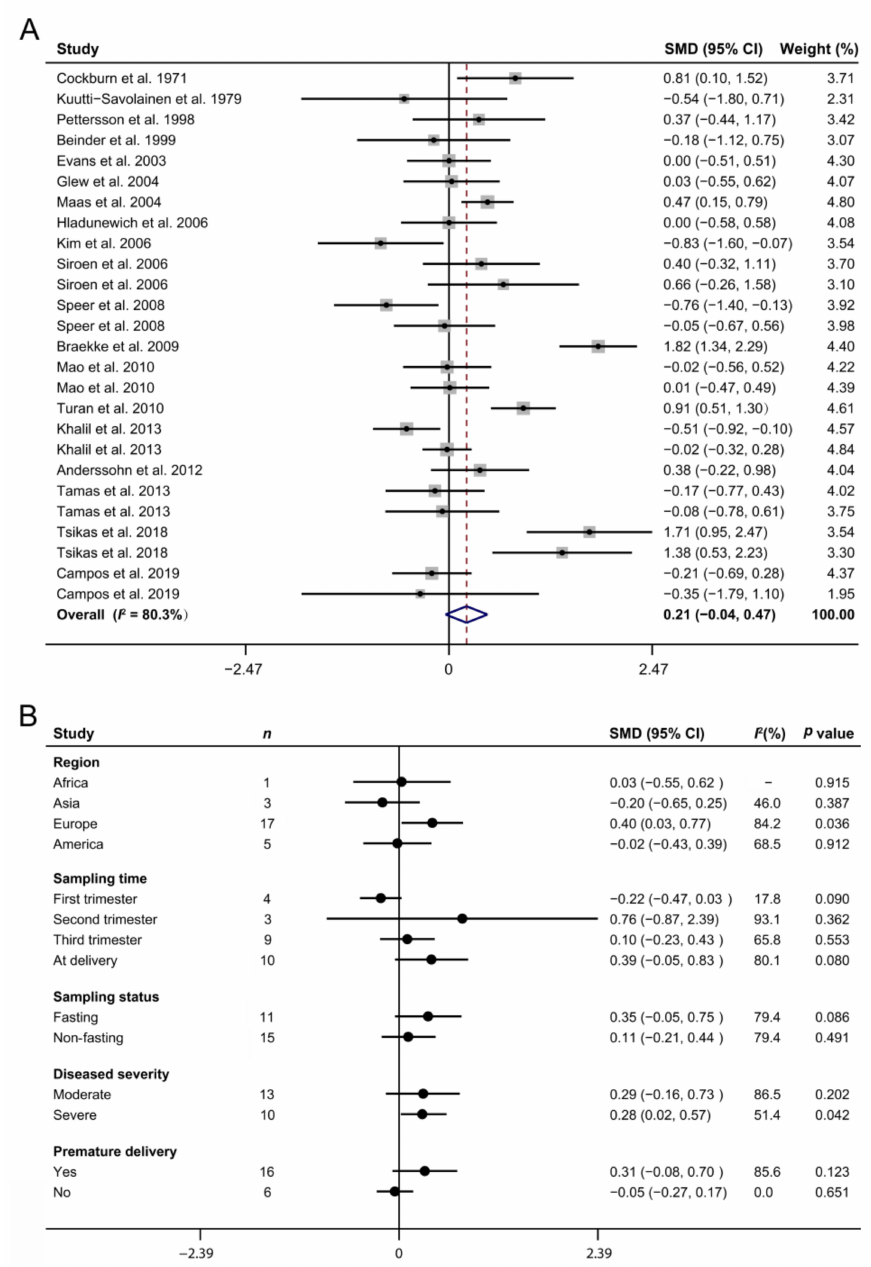
Figure 3. The forest plot depicts the maternal arginine concentrations in preeclampsia pregnancies ( A ) as well as their subgroup analyses ( B ). The solid black circles mean the estimate of SMD. The horizontal lines indicate the 95% CI of this effect, and the sizes of the gray boxes suggest the relative weight of each publication. An open diamond denotes the overall SMD determined using a random effects model. The value on the x-axis corresponds to the SMD of maternal arginine concentration. Heterogeneity among the publications was estimated using the I 2 statistic, with 0–25%, 25.1–75%, and 75.1–100% representing low, moderate, and high degrees of heterogeneity, respectively. SMD, standard mean